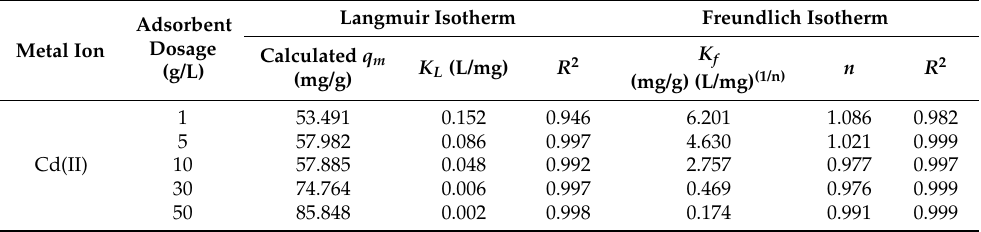
Table 4. Langmuir and Freundlich isotherm parameters for biosorption of Cd(II) using BG